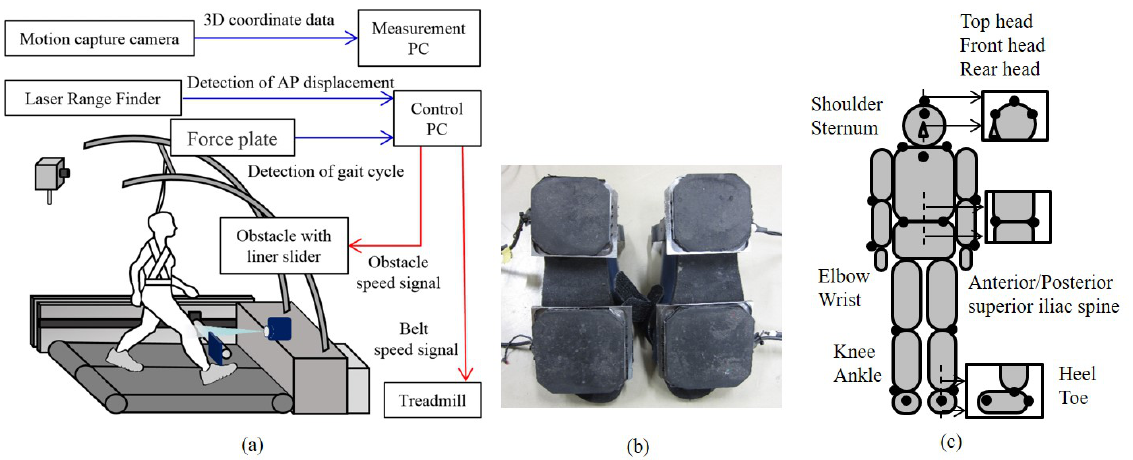
Figure 1. Experimental devices: ( a ) Schematic of tripping treadmill configuration. ( b ) Force plate attached under the sole. ( c ) Locations of 22 motion capture